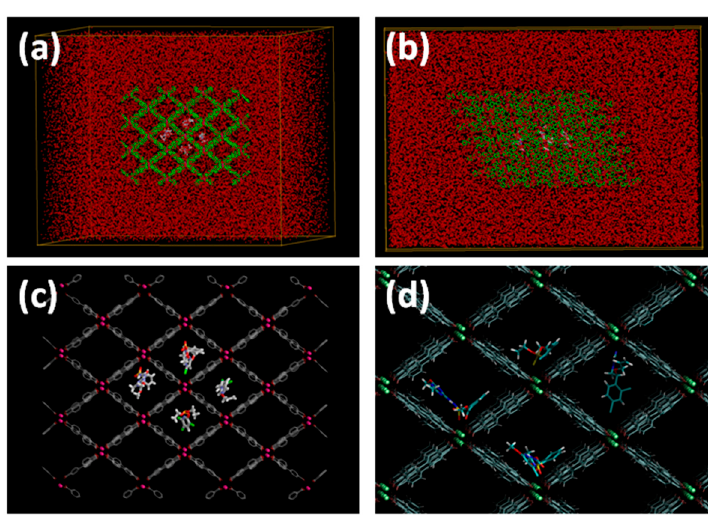
Figure 14. Model system of host–guest interaction ( a , b ) with supercell dimensions of 166 Å × 127 Å × 127 Å (total atoms number: 16,962) constructed by Amber program. Zoom of the pesticides and herbicides into the metal organic frameworks (MOF) ( c , d ) (MOF dimensions (x,y,z): 100 Å × 60 Å × 58 Å).